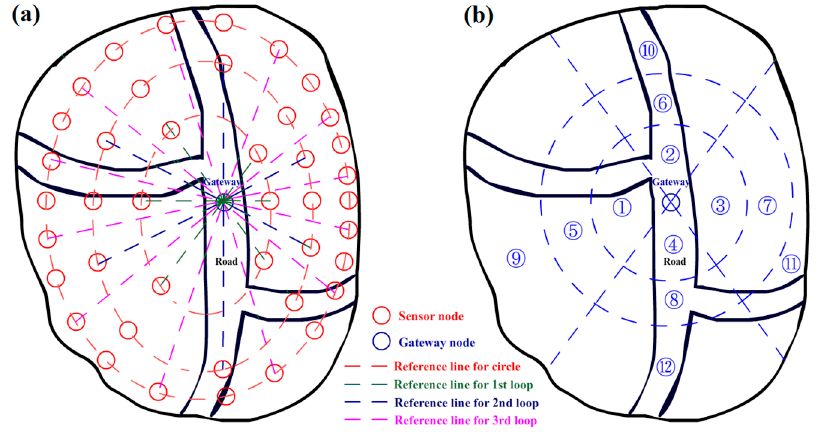
Figure 2. ( a ) Recommended initial arrangement of sensor nodes for a detection system; and ( b ) recommended area division method of sensor nodes for adaptive learning and movement.